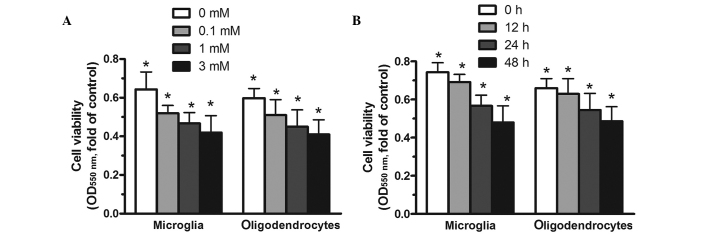
Human microglial and oligodendrocyte cell viability is affected by TAPI-2 in a dose- and time-dependent manner. (A) Human microglia and oligodendrocytes were exposed to TAPI-2 (0.1, 1 or 3 mM) for 48 h. (B) Human microglia and oligodendrocytes were treated with 1 mM TAPI-2 for 12, 24, and 48 h. Cell viability was determined using an MTT assay at 550 nm. Data are expressed as the mean ± standard deviation (n=6; *P<0.05, vs. control). OD, optical density.